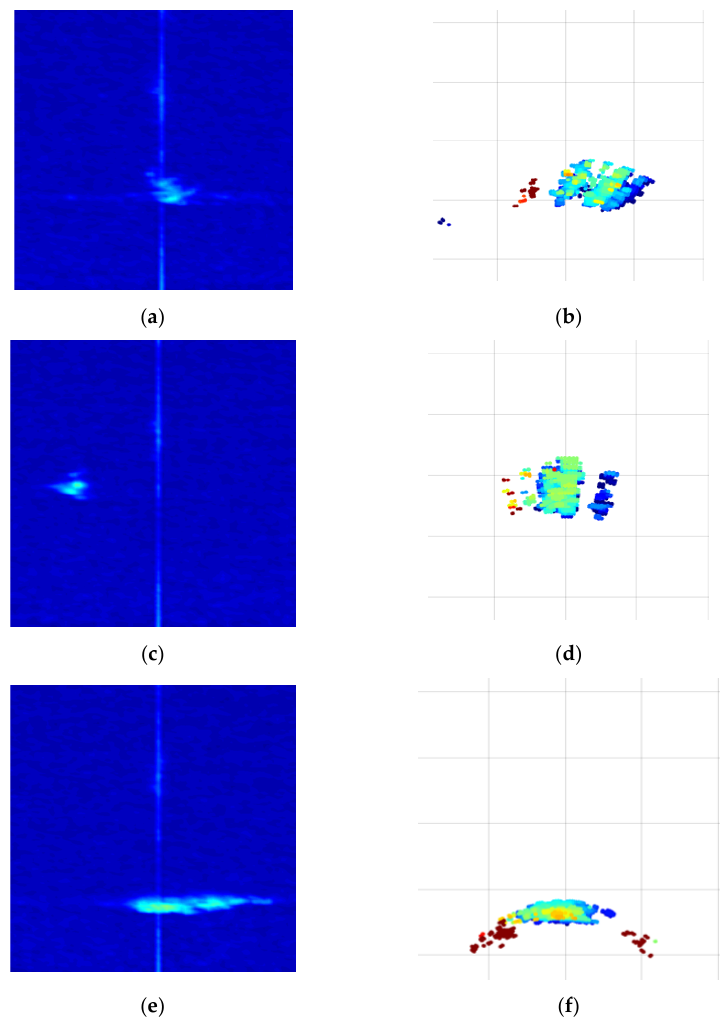
Figure 8. Range–Doppler map and point cloud map when a motorcycle moves: ( a ) range–Doppler map when moving diagonally; ( b ) point cloud map when moving diagonally; ( c ) range–Doppler map when moving vertically; ( d ) point cloud map when moving vertically; ( e ) range–Doppler map when moving horizontally; ( f ) point cloud map when moving